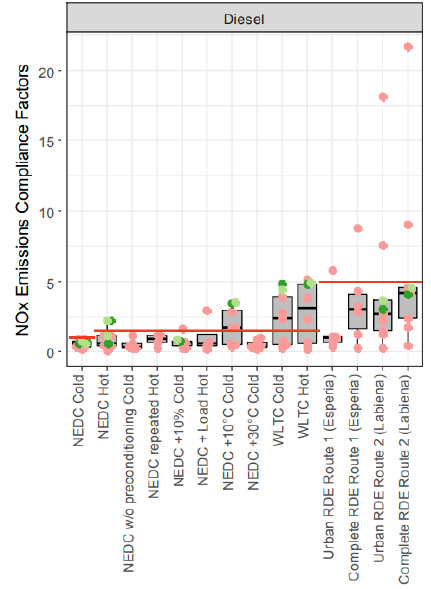
Fig. 6. NO x emissions/NO x standards (Compliance Factors) over laborato- ry and on-road tests. Horizontal red lines indicate limits or recommended thresholds for Compliance Factors. Green and red dots represent individu- al Euro 5b and Euro 6b vehicles, respectively